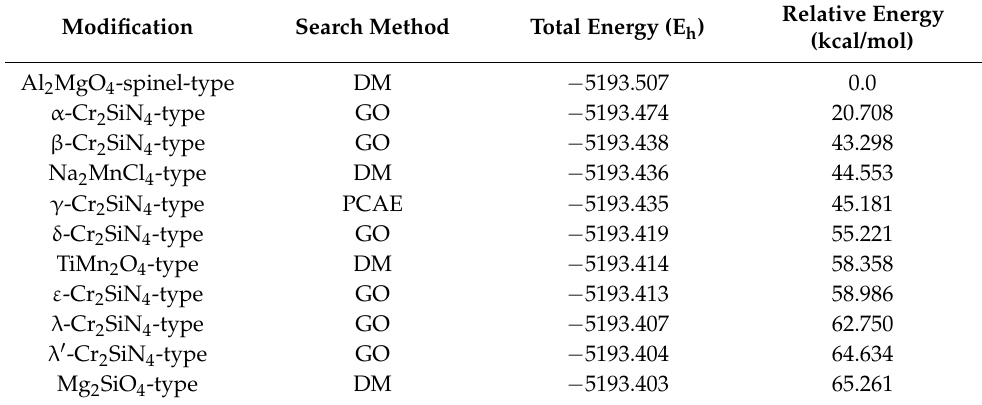
Table 8. The total energies and relative energy values compared to the global minimum (spinel structure taken as the zero of energy) of the energetically most favorable Cr 2 SiN 4 modifications found using various search methods and later locally optimized on the ab initio level using the GGA-PBE functional. DM stands for data mining, GO stands for global optimization, and PCAE stands for Primitive Cell approach for Atom Exchange method.